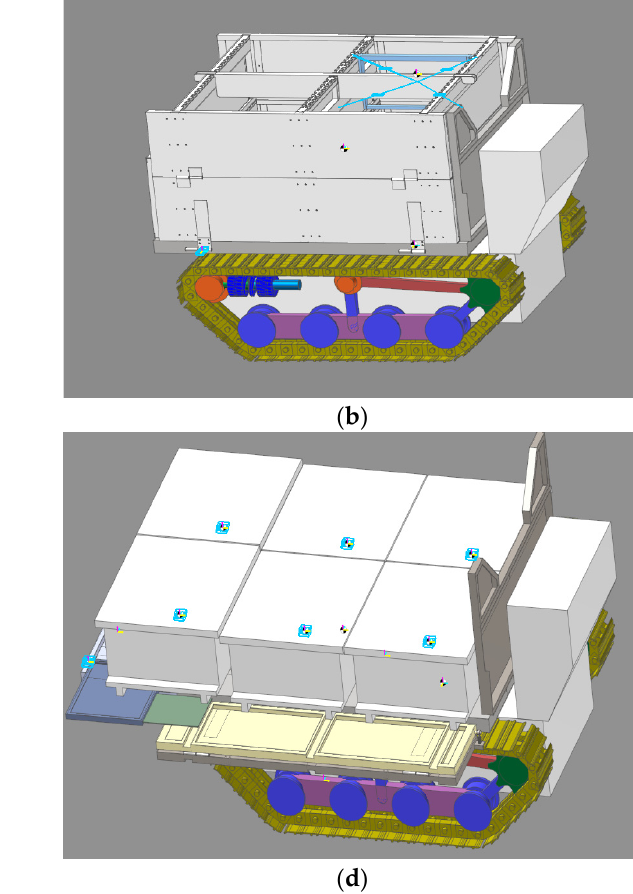
Figure 5. ( a ) Enlarged view of contact relationship between bee frames and interior of loading box, ( b ) tracked vehicle with a single bee frame loaded onto it, ( c ) tracked vehicle fully loaded with bee frames, and ( d ) tracked vehicle fully loaded with beehives.